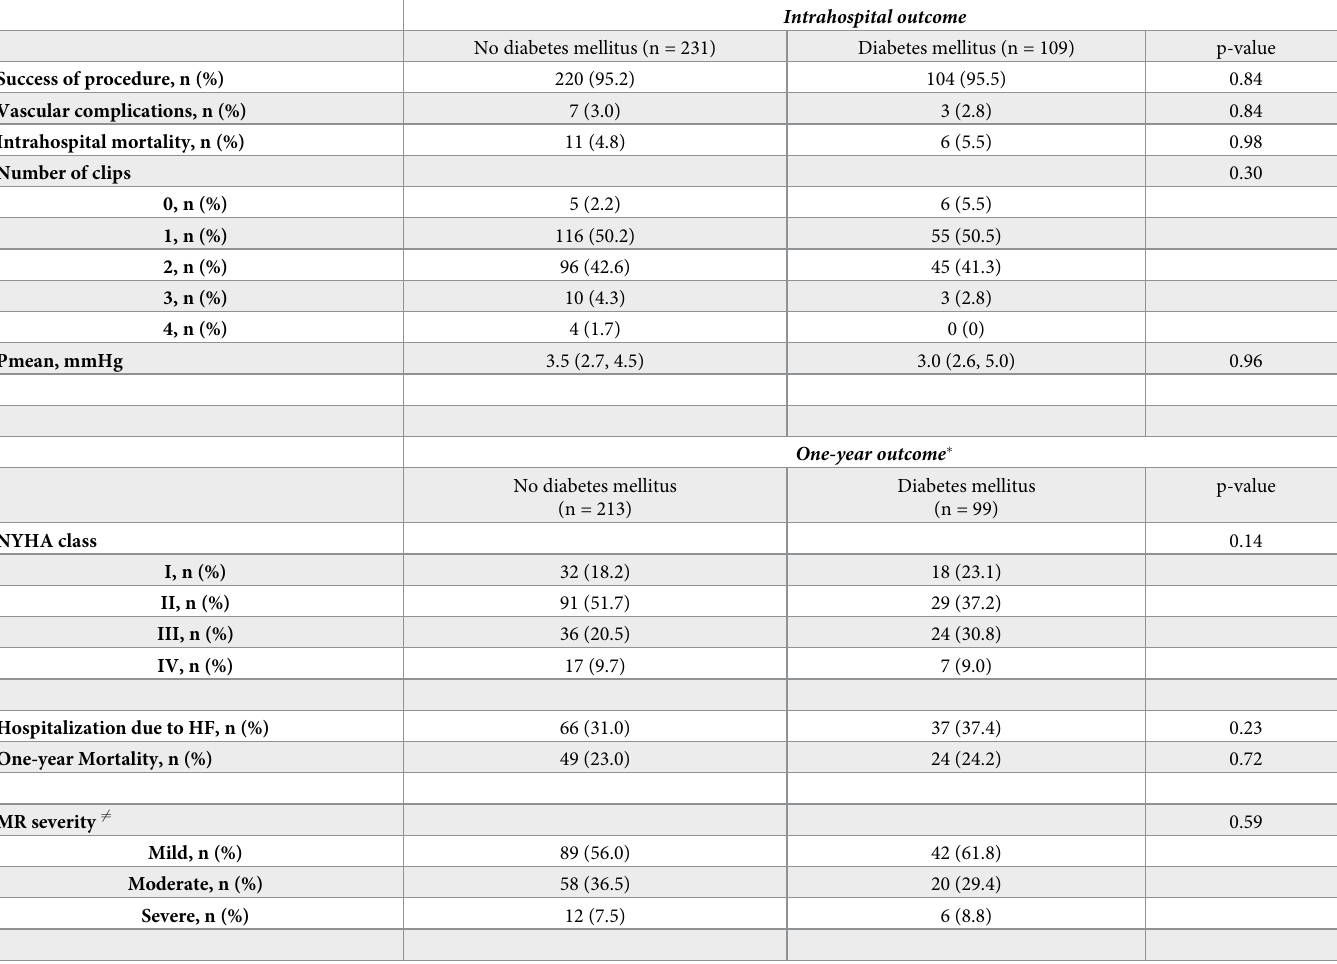
Table 2. Intrahospital and one-year outcome of TEER differentiated between patients without and with diabetes